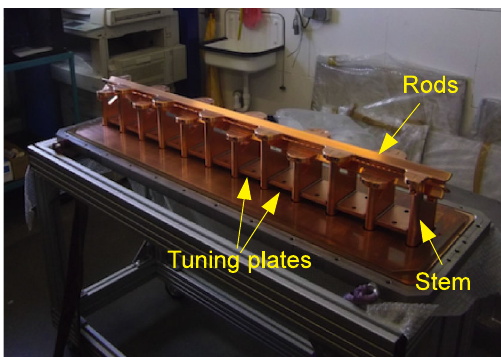
FIG. 1 (color online). This picture shows the FNAL injector RFQ outside of its vacuum tank. The four rods are held by stems and the tuning plates are located between stems. There are 13 tuning cells in this RFQ with 11 full cells and a half cell at each end (for a total of two half cells). The beginning and end cell tuning plates are not installed here. When installed, they go between the vacuum tank wall and the first and last